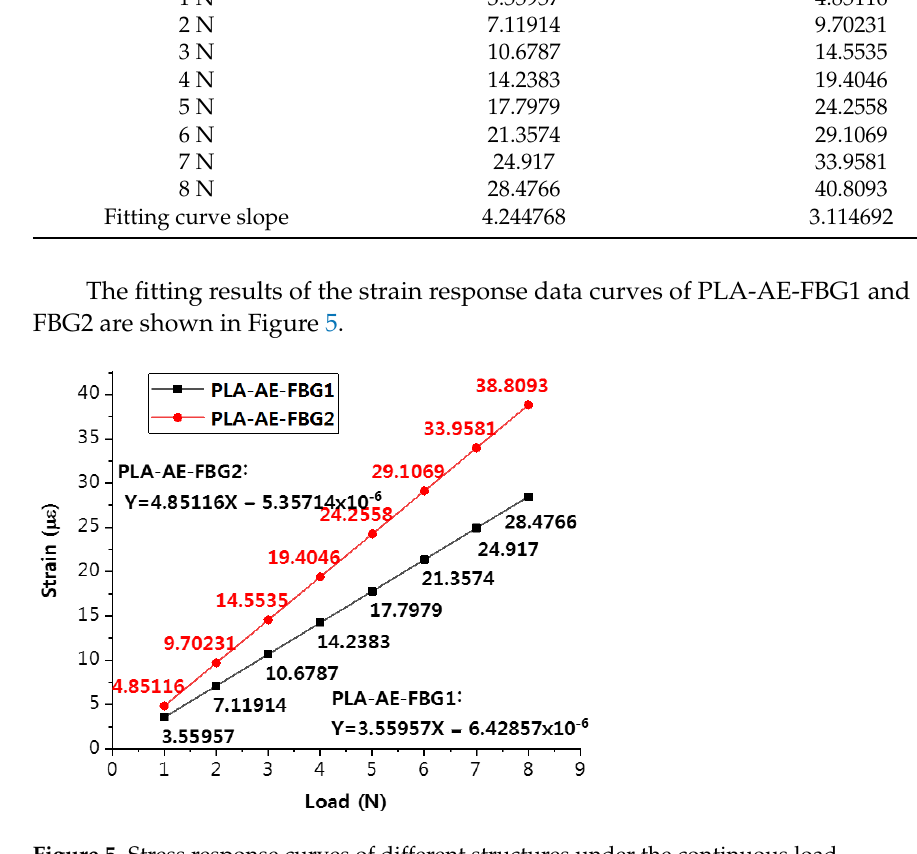
Figure 5. Stress response curves of different structures under the continuous